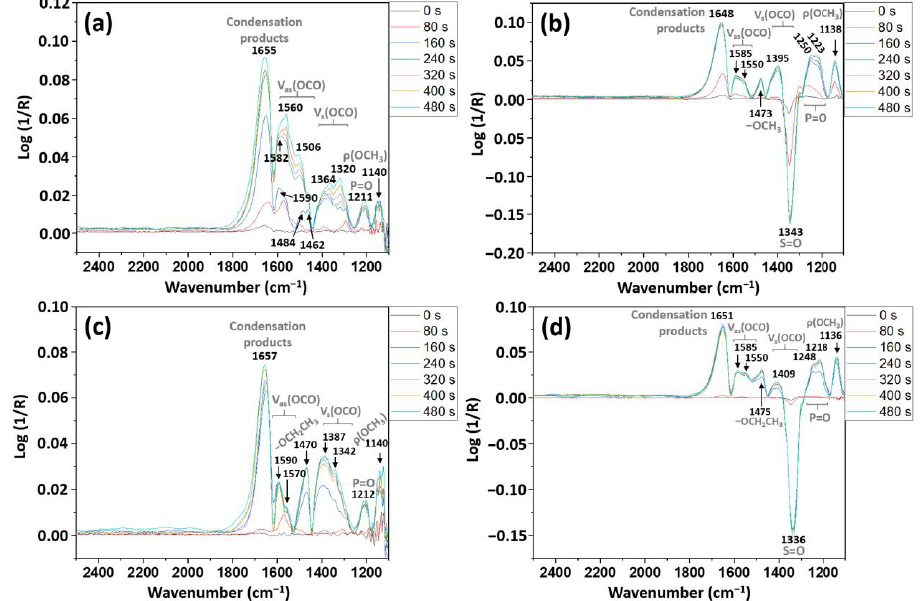
Figure 4. DRIFT spectra for the adsorption of TMP on UV100 ( a ) and Ti-600 ( b ), TEP on UV100 ( c ) and Ti-600 ( d ) at different time intervals. Positions and assignments for major absorption bands are indicated.